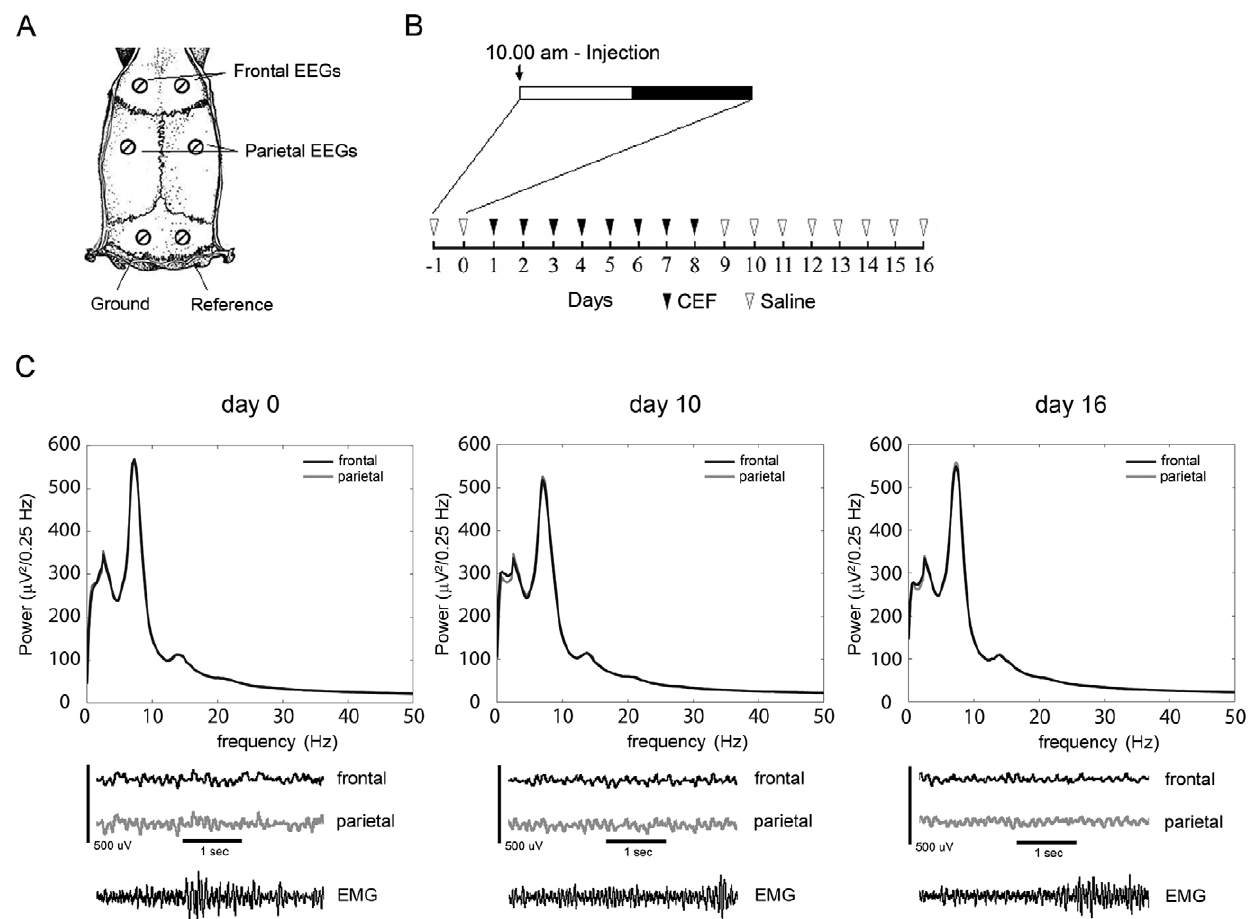
Figure 1. Lack of pathological elements after ceftriaxone treatment. A. Schematic description of electrodes location. B. Saline and CEF Treatment schedule. Day 0 represents the baseline. C. Waking absolute spectra, raw EEG and EMG signals of baseline, day 10 and day 16. Signals appeared stable across the entire length of the experiment and the signal quality was not affected by CEF treatment.